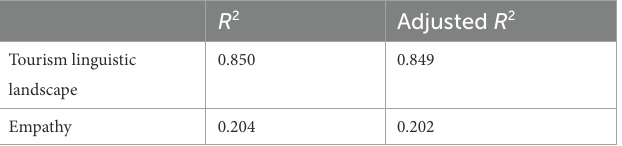
TABLE 1 Predictive power of the model.